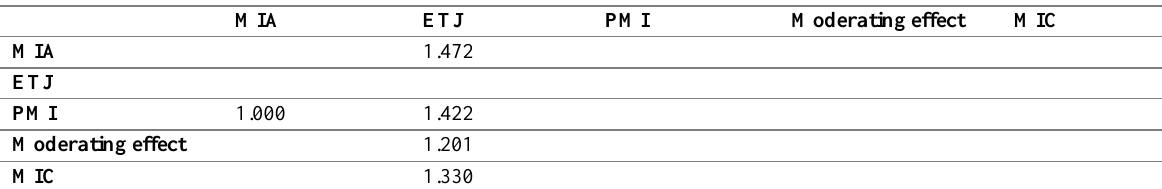
Table 3 : Collinearity Statistics (VIF)